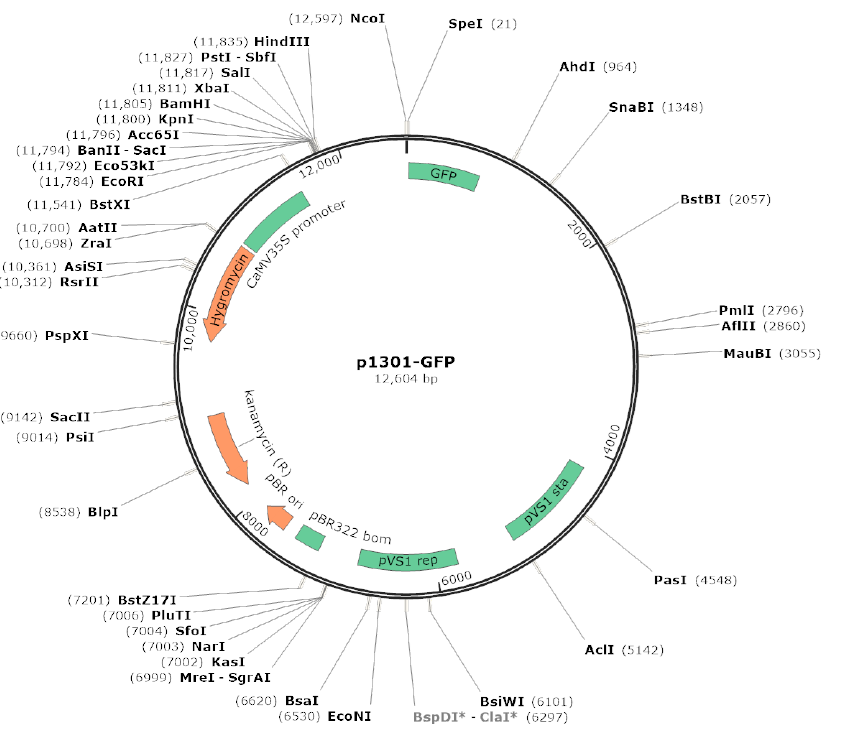
Figure A6. Map of the vector used for subcellular localization of Xs GAO1 and Xs GAO2 created with SnapGene. BspDI* and ClaI* are isoschizomers.